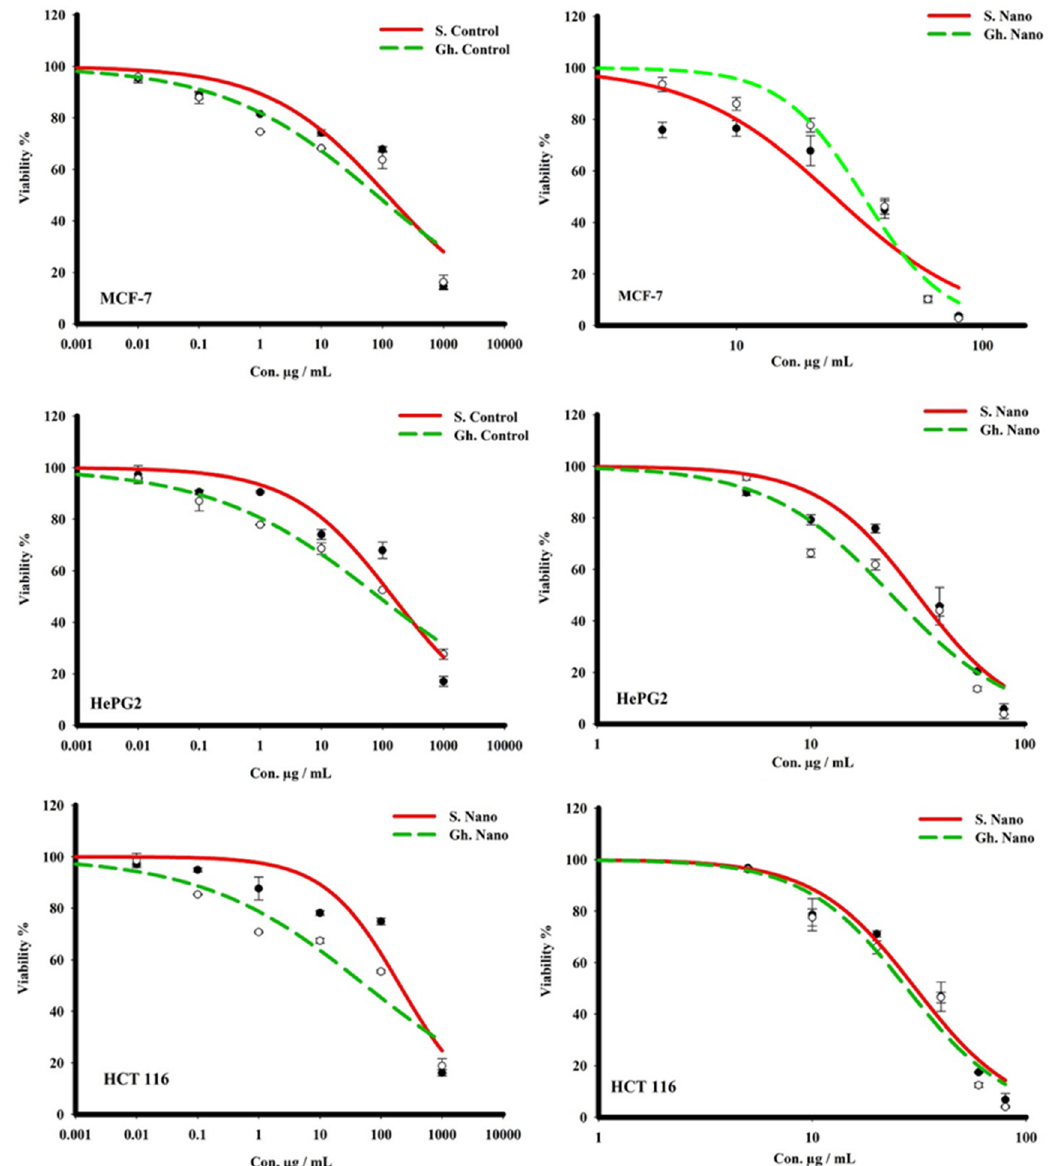
Figure 8. The different IC 50 s of honey (Gh = Forest and S = Sider) and honey and nanoparticles against three human tumor cell lines.